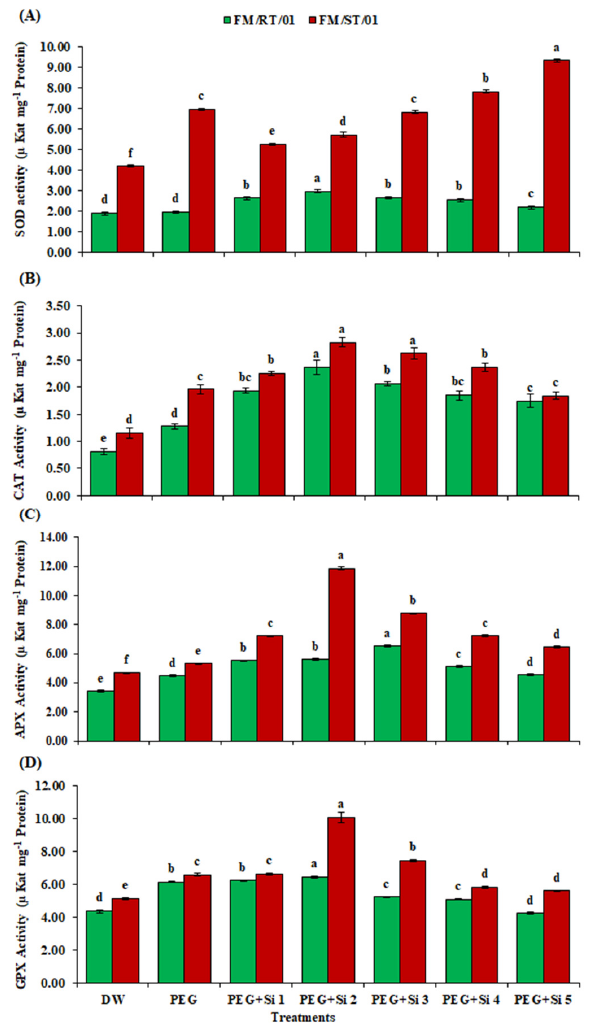
Figure 3 Effect of Si on antioxidant enzyme activities in seedlings of local finger millet landraces under PEG-6000 induced osmotic